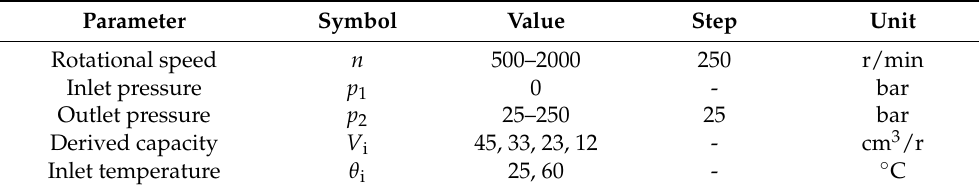
Figure 4. Measurement system. Table 2. Values of the measurement parameters. Pressure values indicated in relation to atmospheric pressure. Maximum displacement of the measured nine piston pump is 45 cm 3 /r, nominal pressure 280 bar, and maximum rotational speed 2600 r/min.